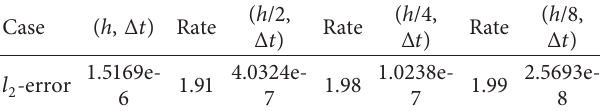
Table 8: Convergence test results of the CN method for space step.